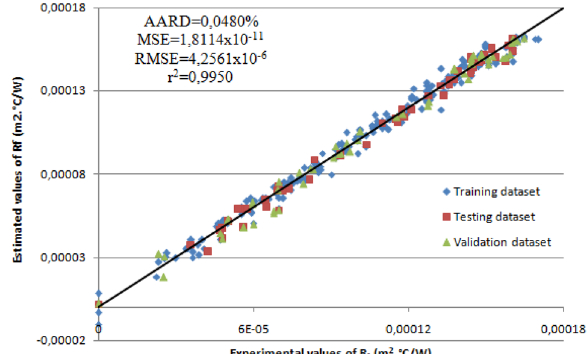
Figure 5. ANN estimation versus experimental results.